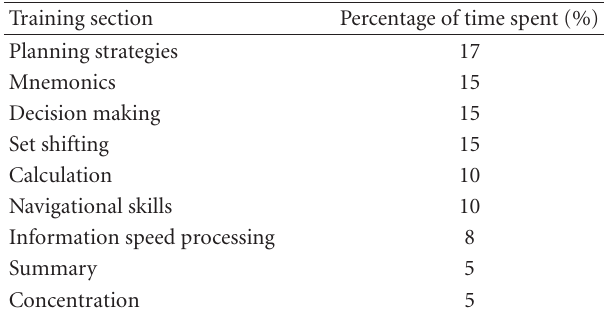
Table 4: Distribution of cognitive training.